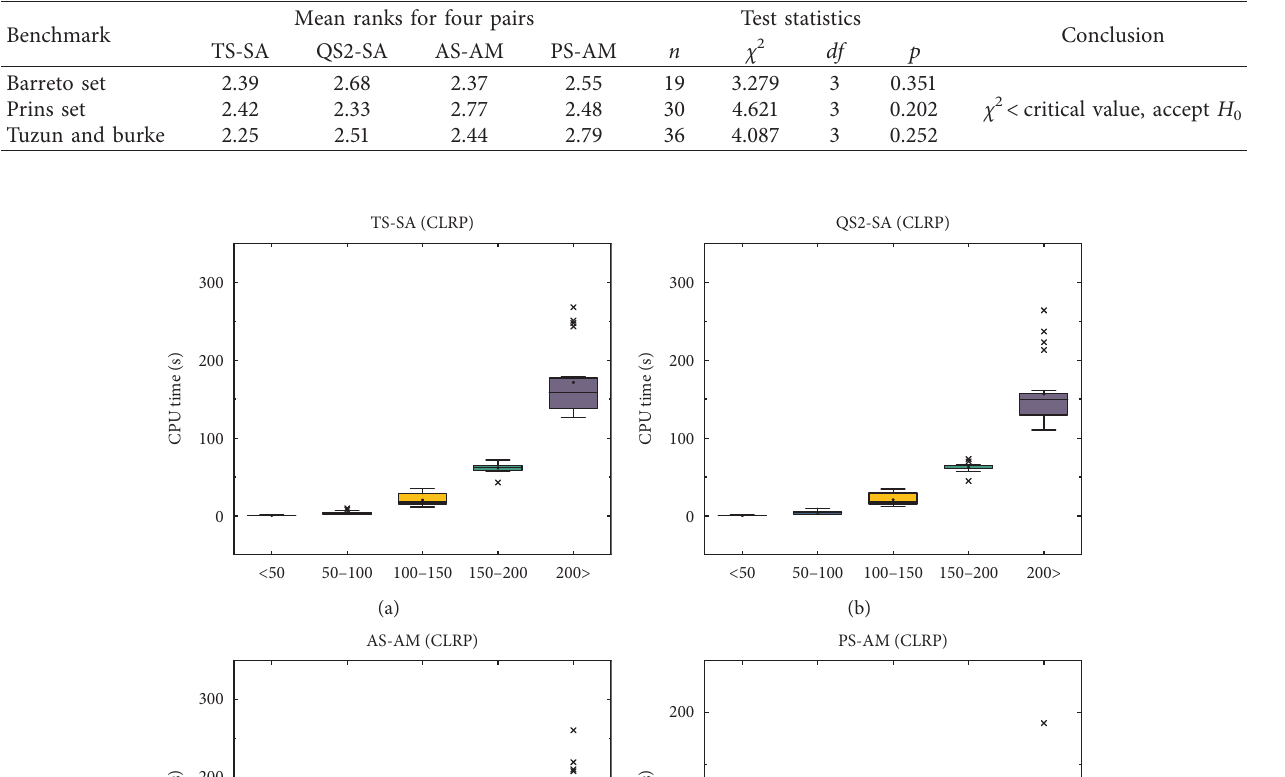
Table 11: Friedman’s test results for CLRPSPD benchmark instances ( α �